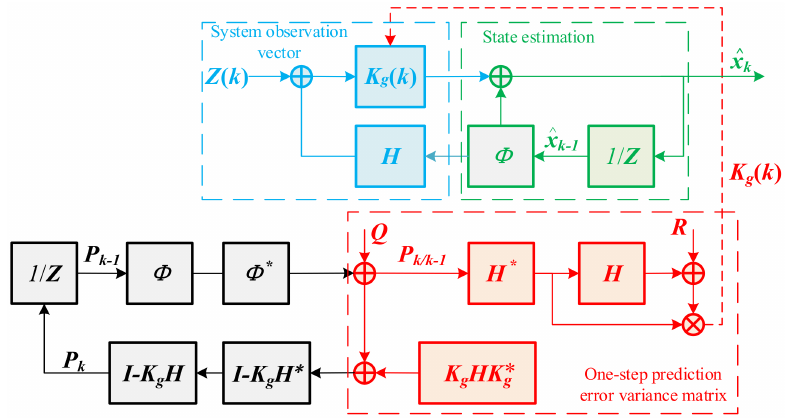
Figure 10. The flow diagram of Kalman filter algorithm.